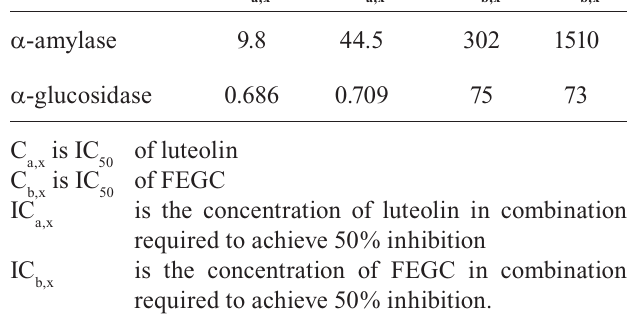
Flavonoid α -amylase